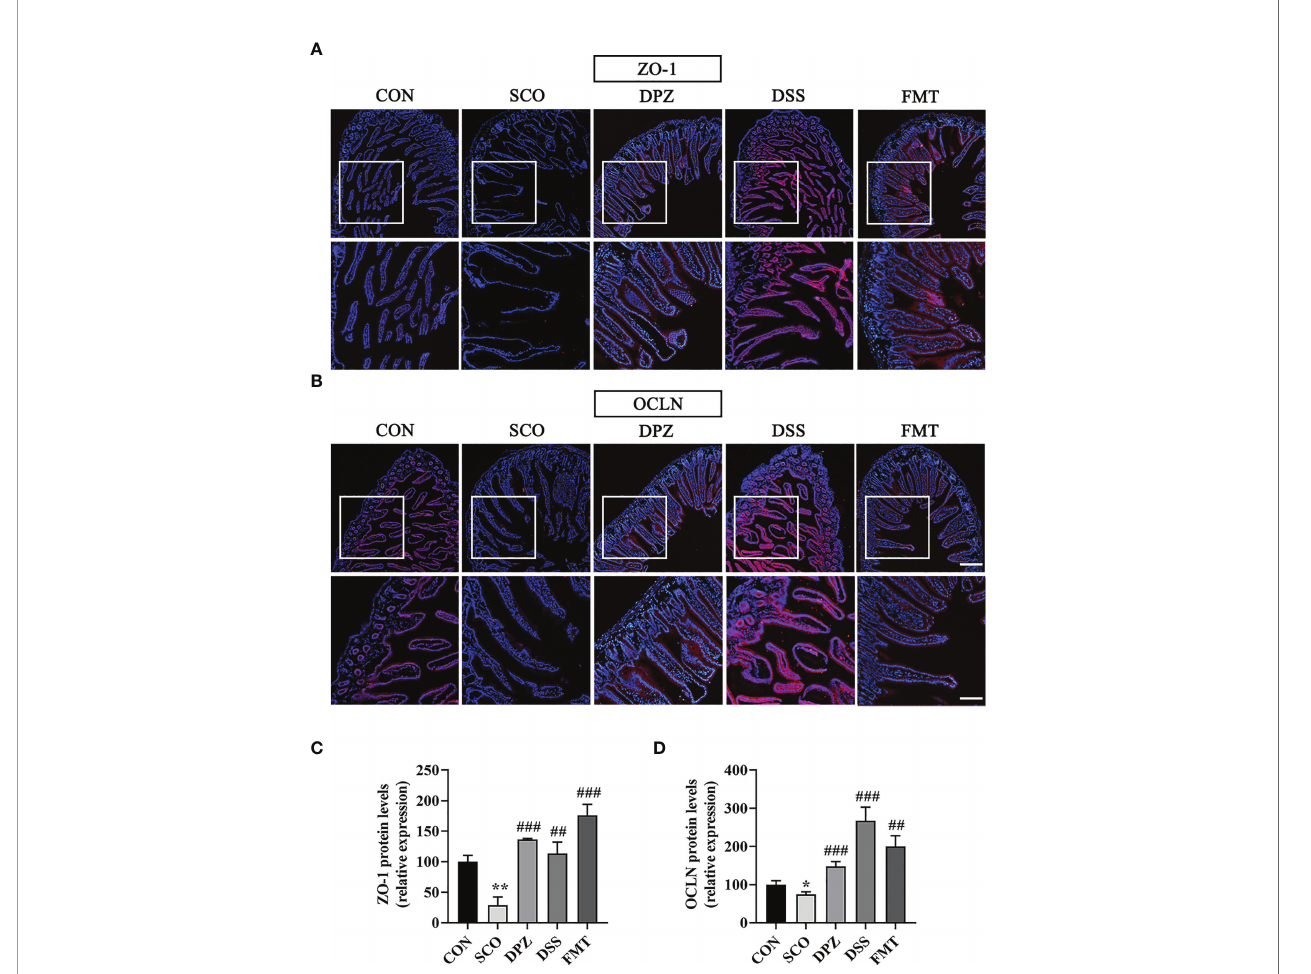
FIGURE 9 | The protective effects of (A, B) on the intestinal barrier. For immuno fl uorescence staining of ZO-1, OCLN (red colour) in jejunum tissue, stained slides with the CON, SCO, DPZ, DSS and FMT groups. Immuno fl uorescence staining of ZO-1 (A) and OCLN (B) was observed under a fl uorescence microscope at ×10 magni fi cation (bar = 200 m m) and ×20 magni fi cation (bar = 100 m m). ZO-1 (C) and OCLN (D) was represented by fl uorescence quantitative statstics (n =3), * p < 0.05, ** p < 0.01, vs. CON, ## p < 0.01, ### p < 0.001, vs.